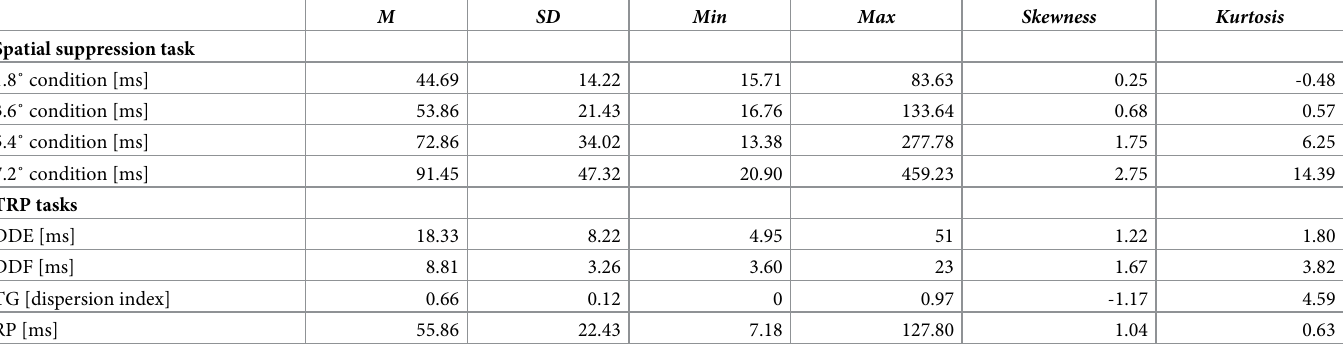
Table 1. Descriptive statistics for the motion-direction detection thresholds in the four conditions of the spatial suppression task, for the difference limina in the duration discrimination tasks (DDE, DDF), for the dispersion index in the temporal generalization task (TG), and the mean 75% difference threshold in the rhythm perception (RP) task in the sample of 273 participants.